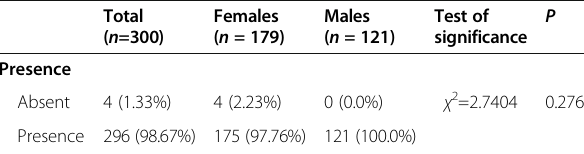
Test of significance